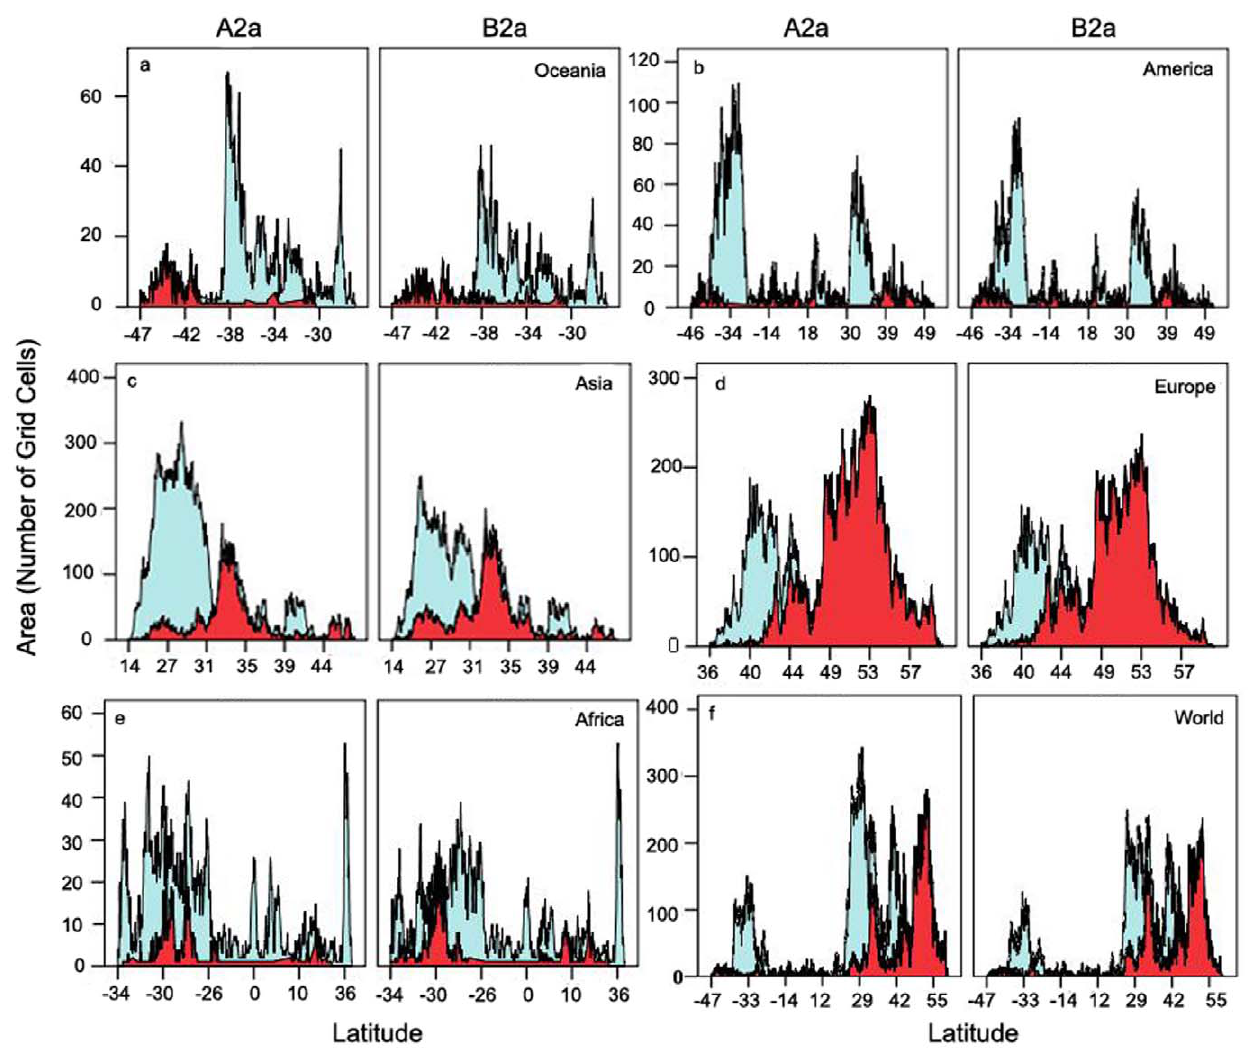
Figure 3. Climate change, biogeography and shift in range size of future invasive potential of P.clarkii . Projected latitudinal pattern of suitability changes between the present year and 2050 for two scenarios (A2a and B2a) with global climate change (blue, current suitable areas projected to be lost; and red, the proportion of areas projected to become suitable). The predicted suitability is based on the 10th percentile training presence threshold. doi:10.1371/journal.pone.0018429.g003 PLoS ONE |